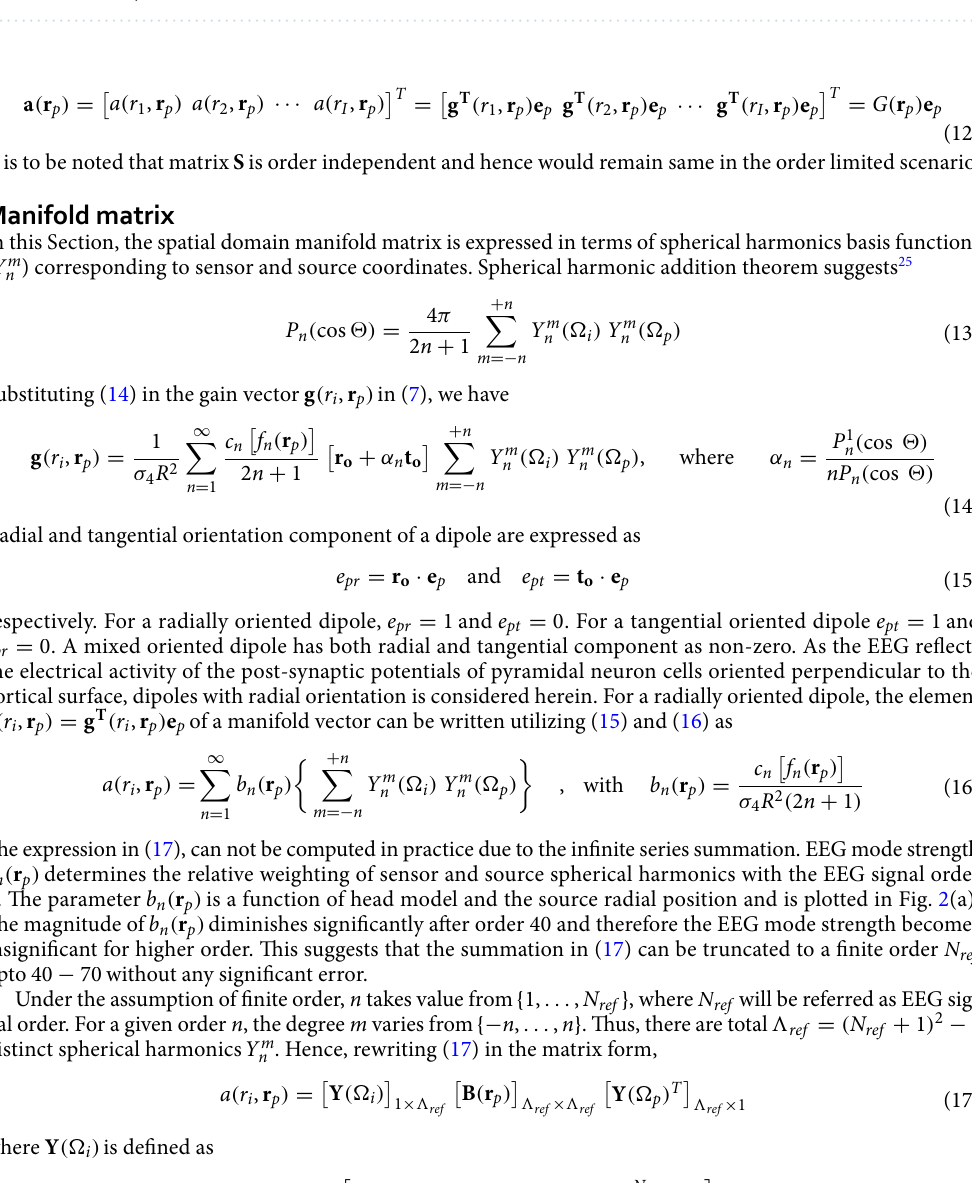
Figure 2. ( a ) EEG mode strength b n ( r p ) with order n of different source eccentricity. ( b ) The 2-D axial termed as ROI was taken at the depth of 3.2 cm from the top of the scalp surface. ( c ) Four active sources were placed pseudo-randomly on the